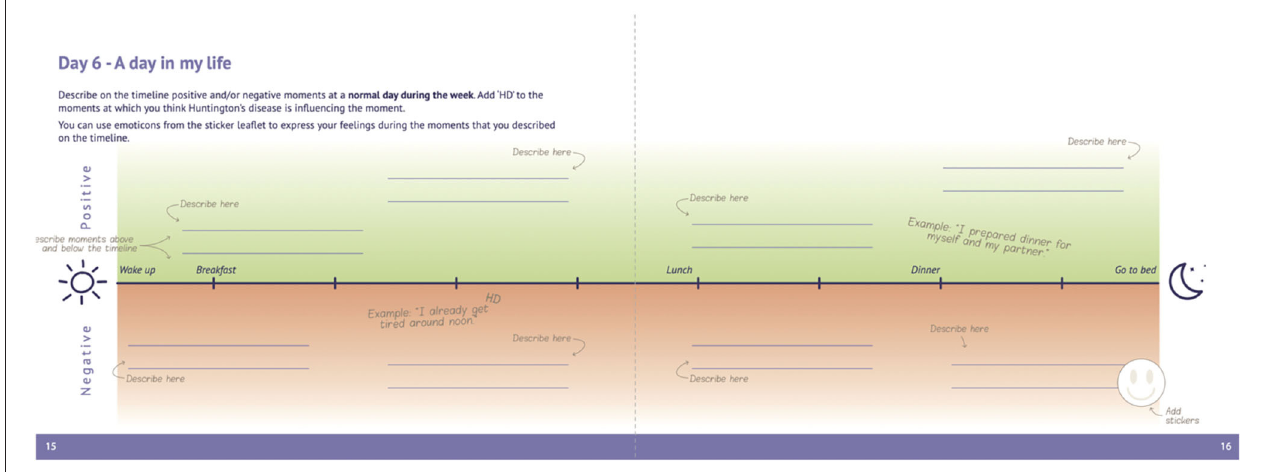
FIGURE 1 | Image of assignment in sensitizing booklet for manifest